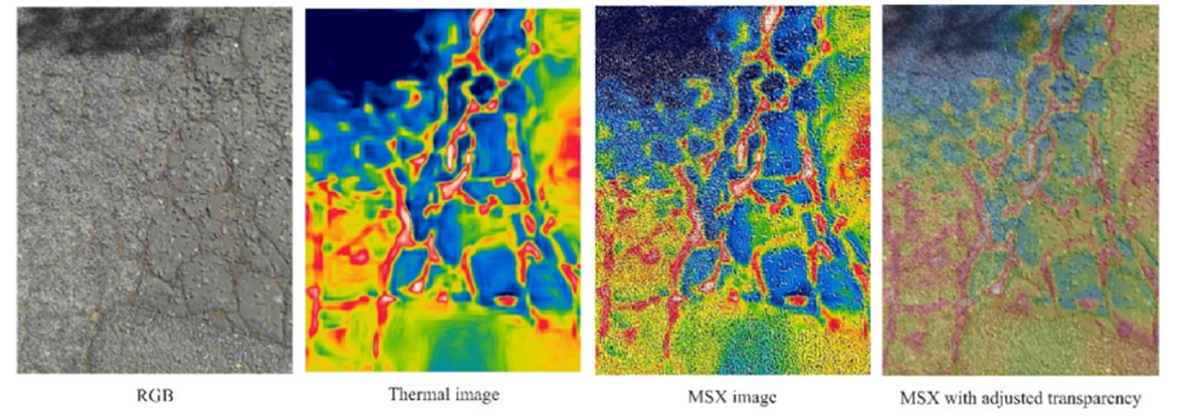
7 of 18 Figure 5. Data augmentation of oil marking, road marking and shadow. 2.4. Multi-Band Dynamic Imaging (MSX) and Its Adjustment FLIR has the capability to add Multi-band Dynamic Imaging (MSX), which provides digital camera-level capture detail in thermal images [39]. MSX takes into account both the texture of the RGB image and the temperature of the thermal image, requiring adjust-